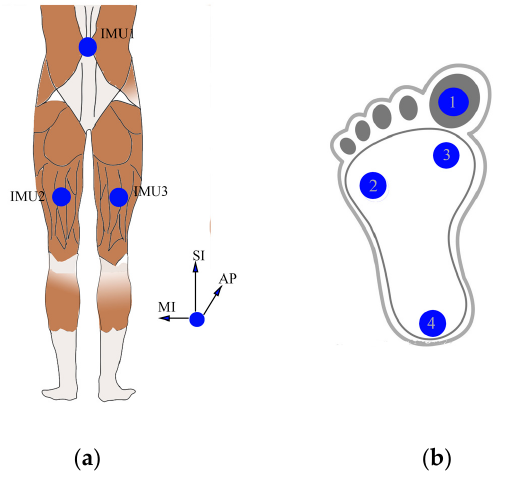
Figure 1. Locations of: ( a ) IMUs, AP, SI and ML represent the anterior–posterior, superior–inferior, medio-lateral directions respectively; ( b ) FSRs (1: toe, 2: fifth metatarsophalangeal, 3: first metatarsophalangeal, and 4: heel).